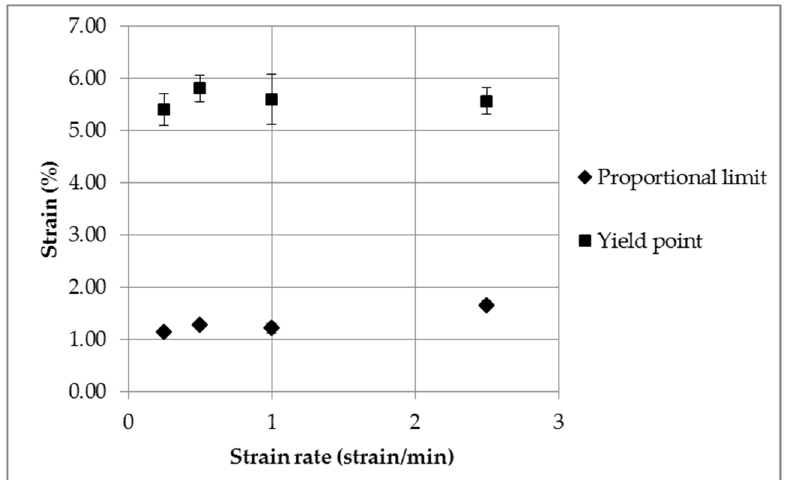
Figure 6. Impact of strain rate on proportional limit and yield point. Each datapoint represents the average of three results, error bars represent sample standard deviation.